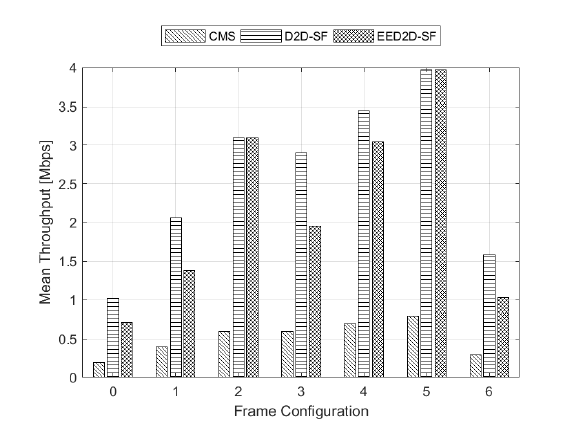
Figure 4. Mean Throughput for all frame configurations.